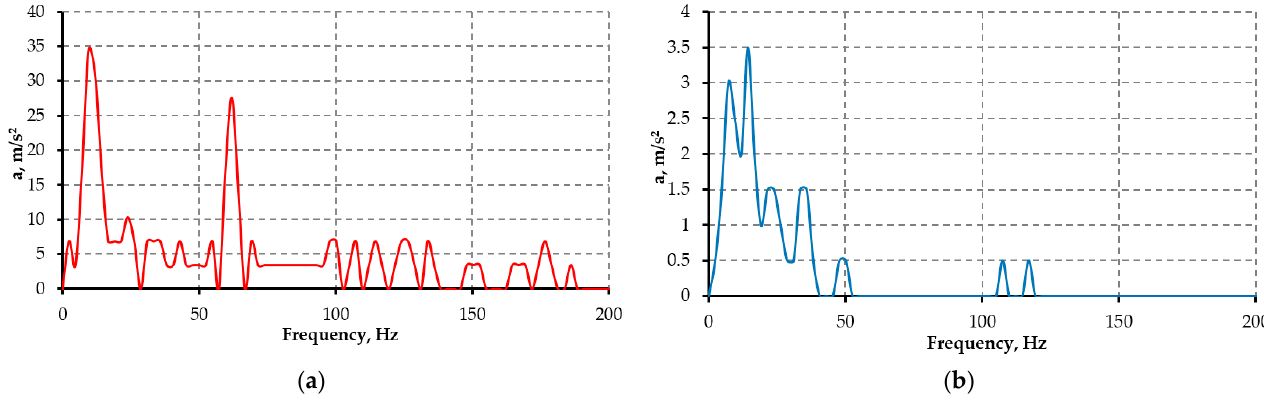
Figure 27. Frequency spectra of compact car on city type road at the speed of 70 km/h: ( a )—front, unsprung mass and ( b )—front, sprung mass.